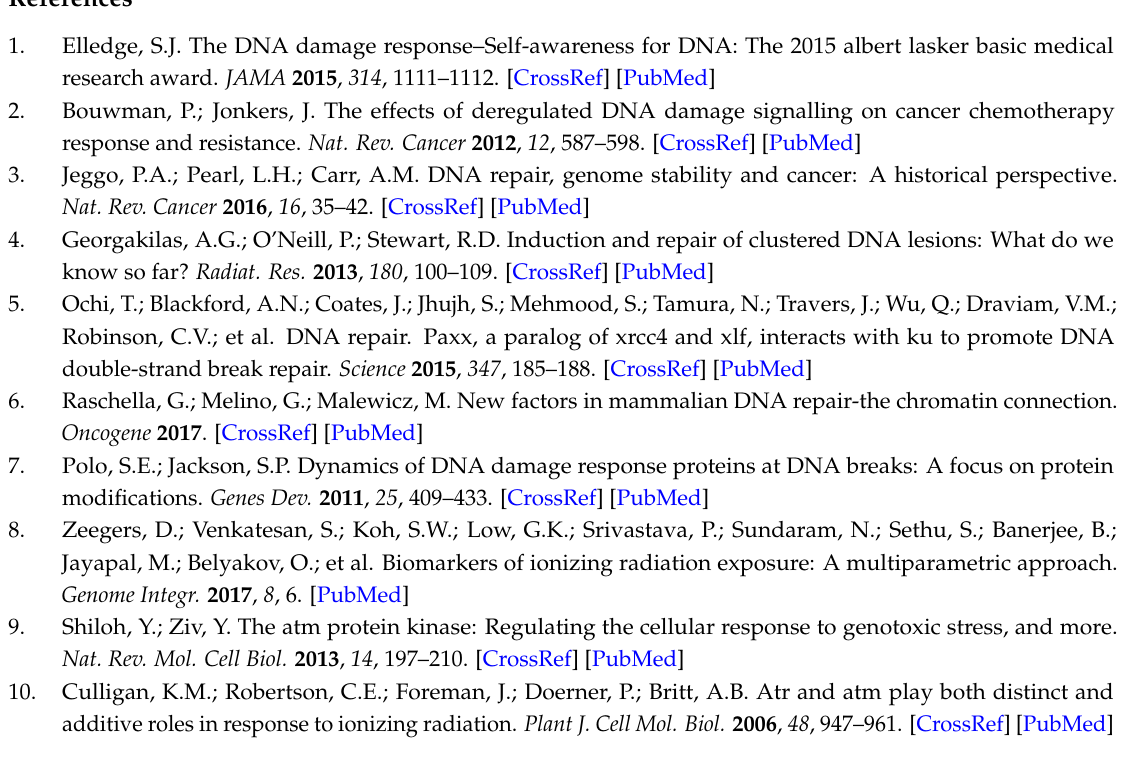
Table S1: Human DNA repair genes. Contents of the Venn diagram presented in Figure 5 in the main text, Table S2: Arabidopsis thaliana DNA repair genes. Contents of the Venn diagram presented in Figure 6 in the main text, Table S3: Homo sapiens genes that stemmed from the present analysis (i.e., contents of the Venn diagram shown in Figure 8 in the main text), Table S4: Arabidopsis thaliana genes that stemmed from the present analysis (i.e., contents of the Venn diagram shown in Figure 9 in the main text), Table S5. DNA repair genes in human and Arabidopsis thaliana, grouped according to orthology, Table S6: BER genes in human and Arabidopsis thaliana, grouped according to orthology, Table S7: NER genes in human and Arabidopsis thaliana, grouped according to orthology, Table S8: MMR genes in human and Arabidopsis thaliana, grouped according to orthology, Table S9. HR genes in human and Arabidopsis thaliana, grouped according to orthology, Table S10: NHEJ genes in human and Arabidopsis thaliana, grouped according to